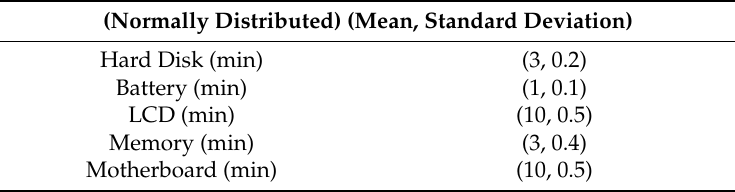
Table A4. Subassembly and component replacement times for maintenance.